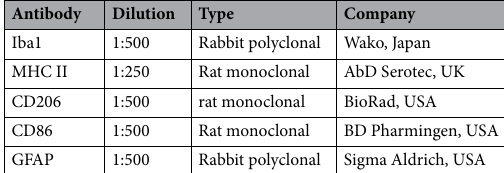
Table 1. List of antibodies for